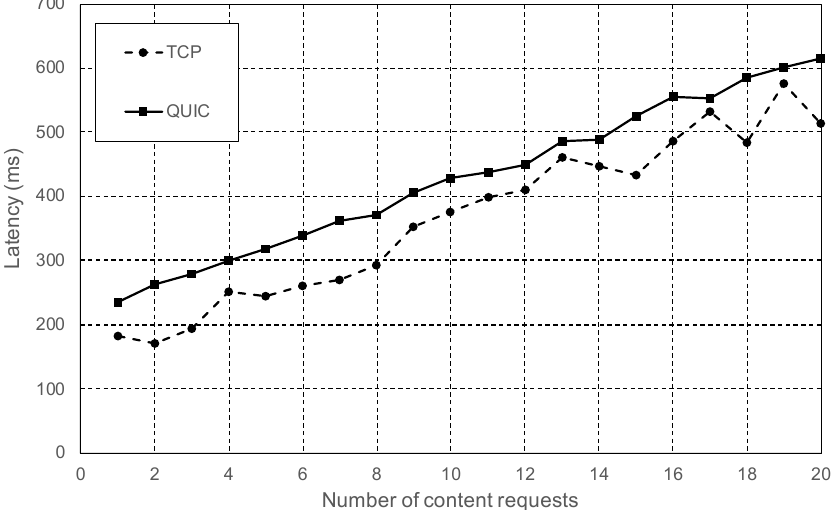
Figure 10. Total time required to fetch content from another node, including the initial